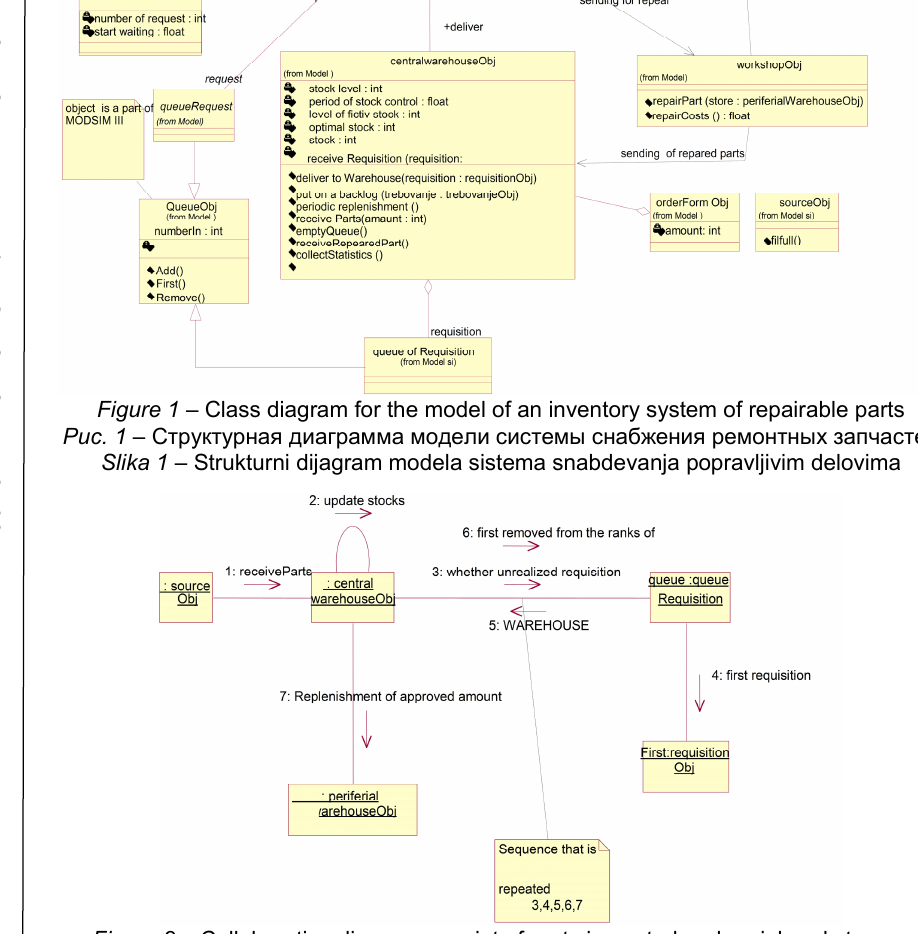
Figure 2 – Collaborative diagram: receipt of parts in central and peripheral storage Рис . 2 – Диаграмма кооперации : прием запчастей на центральный и периферийные Slika 2 – Kolaboracioni dijagram: prijem delova u centralno i periferno skladište